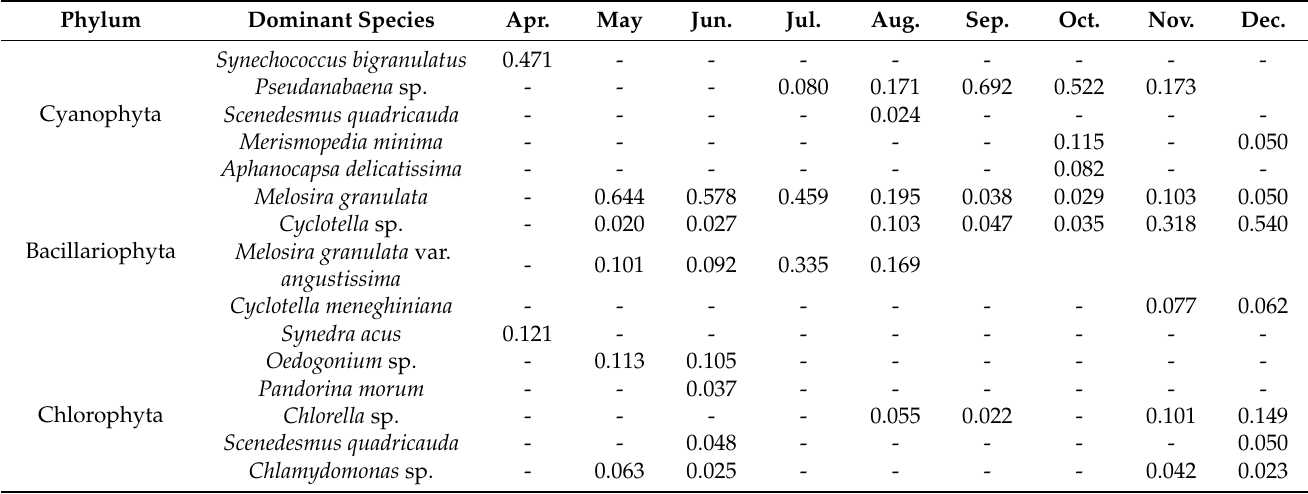
Note: - represents that species were not dominant during the period.